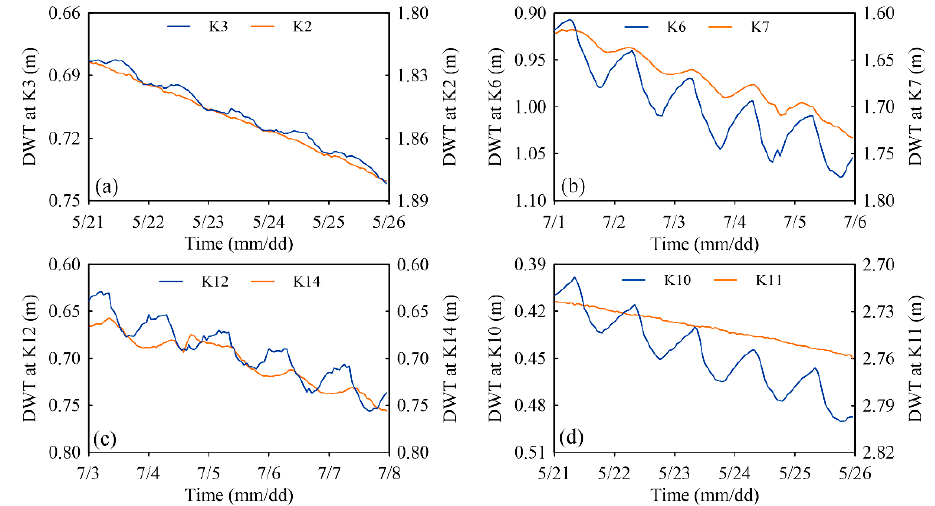
Figure 6. The water table fluctuations vary with ( a ) the DWT in Achnatherum splendens site and ( b ) DWT in Salix psammophila site, ( c ) the vegetation conditions in the same DWT, and ( d ) the microrelief. Vegetation condition is also a vital influencing factor of water level fluctuation